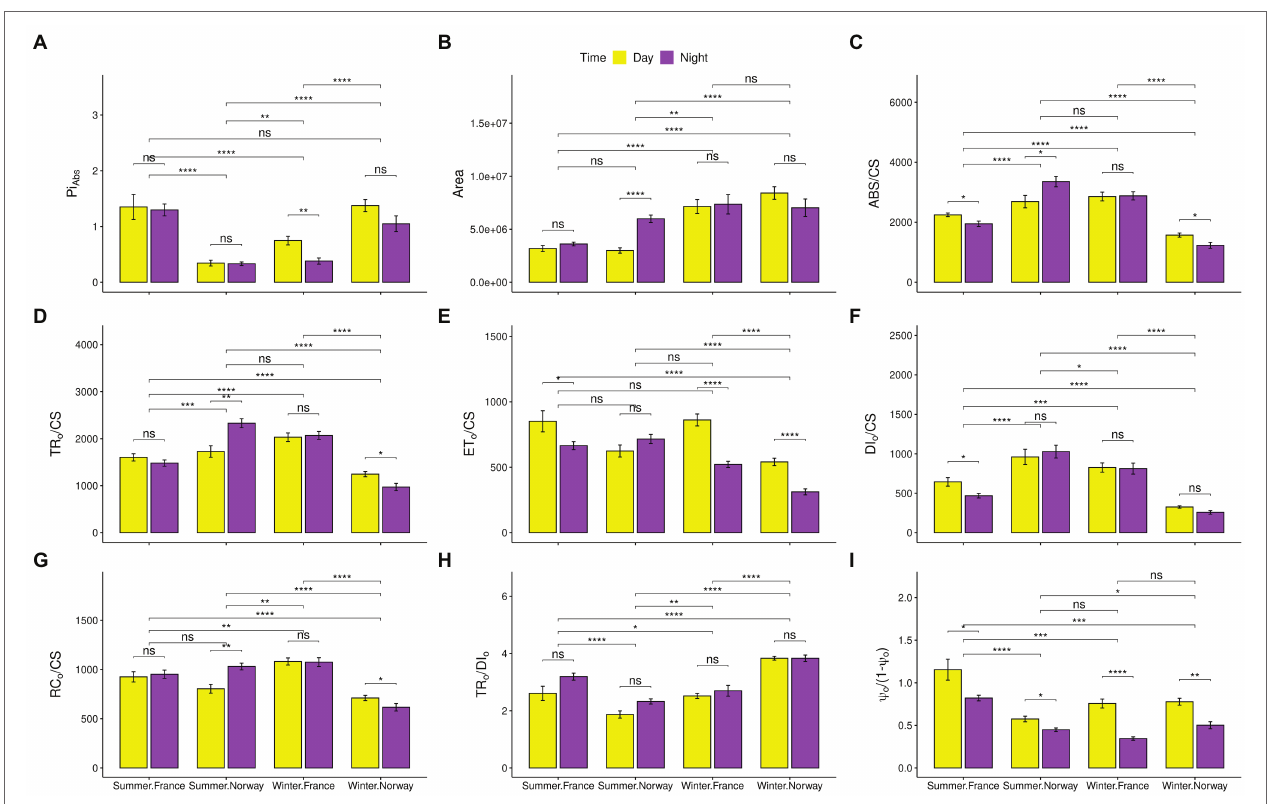
FIGURE 2 | Photosynthetic characteristics. Snapshots of photosynthetic characteristics with standard error bars and indications for significant differences between populations, day and night, or summer and winter. Significance codes after the value of p correction (Benjamini-Hochberg) for multiple comparisons: “<0.05”: *, “<0.01”: **, “<0.001”: ***, “<0.0001”: ****. (A) Index of photosynthetic performance (PI ABS ). (B) Size of the oxidized quinone pool (Area). (C) Absorption per excited cross-section (ABS/CS). (D) Trapping per excited cross-section (TR 0 /CS). (E) Electron transport per excited cross-section (ET 0 /CS), (F) Dissipated energy flux per excited cross section (DI 0 /CS). (G) Oxidized reaction centers per excited cross-section (RC 0 /CS). (H) Contribution of the light reactions to the primary photochemistry (TR